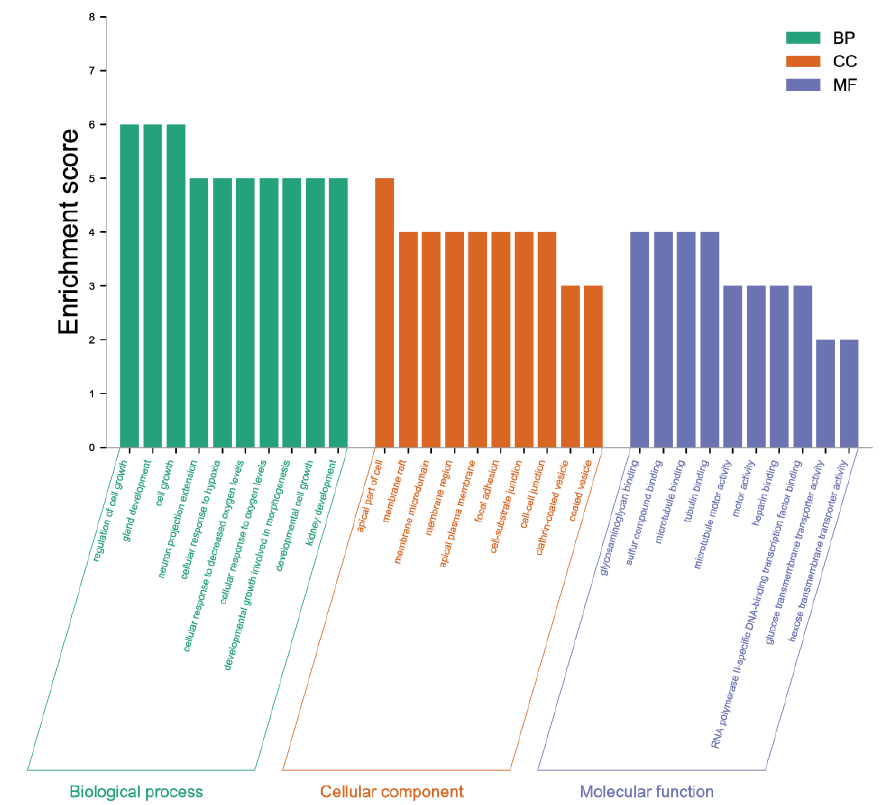
Figure 6. Column chart of GO enrichment analysis of differently expressed genes. The screened DEGs were separated into three main categories: Biological processes, cellular components, and molecular functions.